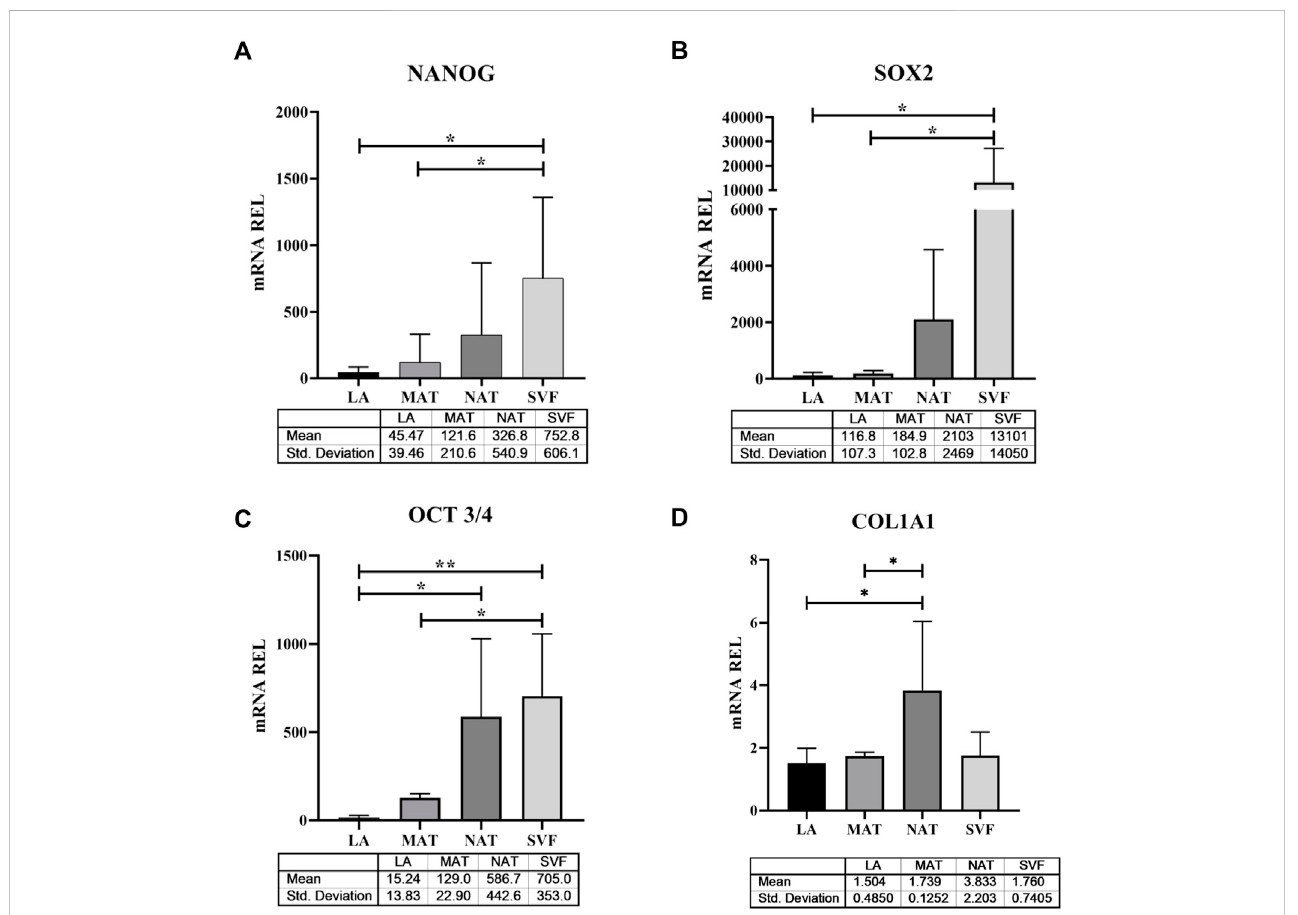
FIGURE 5 Stemness-related transcription factor and extracellular matrix gene expression in lipoaspirate (LA), micro-fragmented (MAT), nanofat (NAT) and stromal vascular fraction (SVF) samples. (A) NANOG gene expression levels; (B) SOX2 gene expression levels; (C) OCT3/4 gene expression levels; (D) COL1A1 gene expression levels. Results are expressed as relative quantity (mRNA REL) of gene levels calculated by the 2 − Δ DCt method, where the value one was assigned to the lowest level of expression. * p ≤ 0.05; ** p ≤